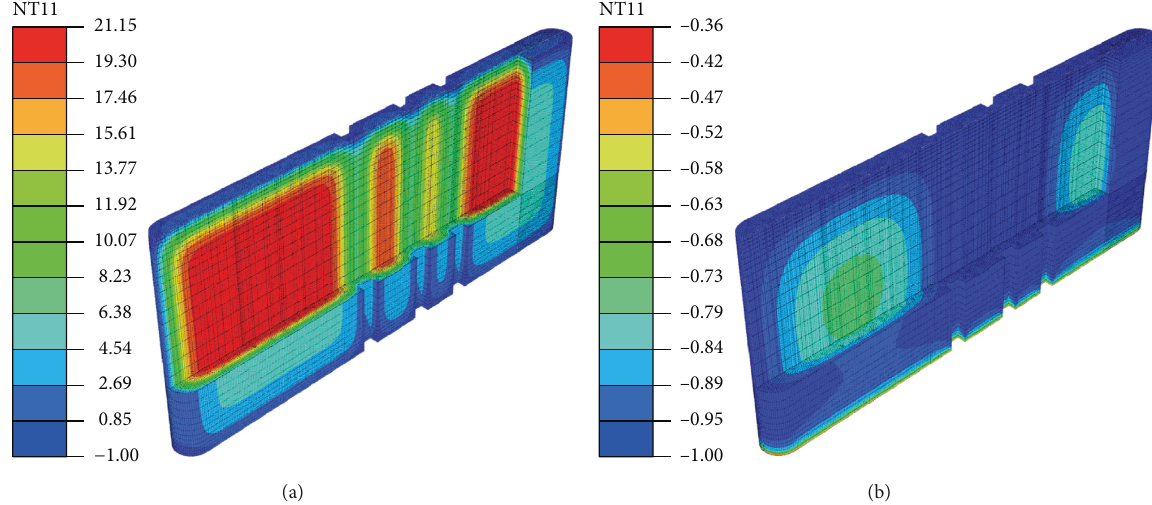
Figure 6: Temperature distributions at 100 hours (a) and 672 hours (b) after casting.